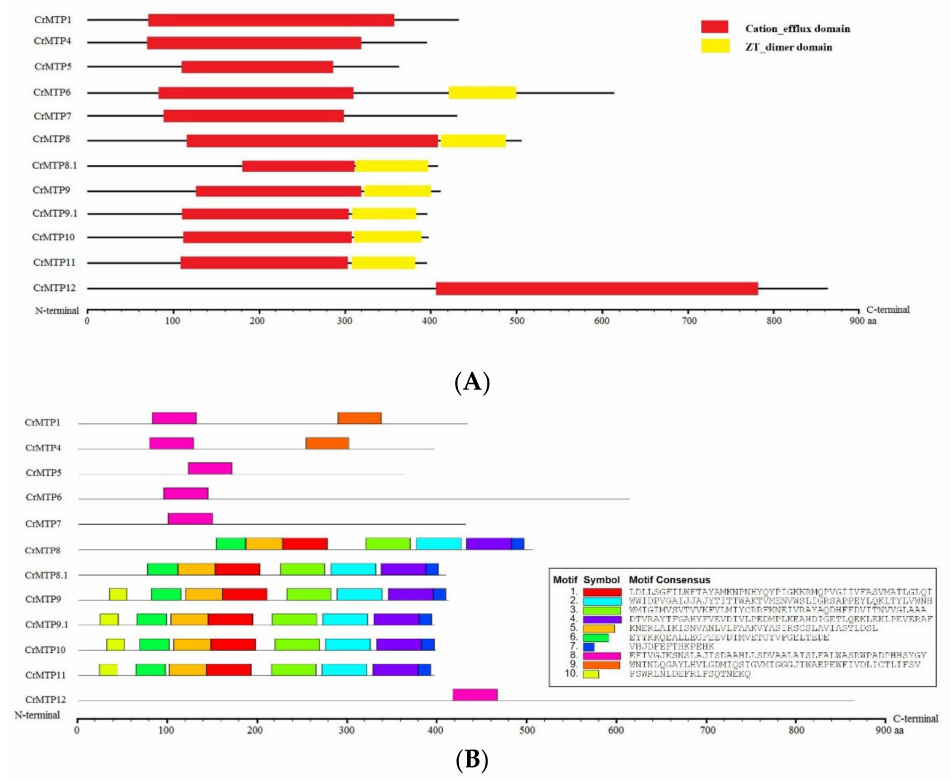
Figure 5. Conserved domains searched by the Pfam database and their conserved motifs discov- ered by Multiple Em for Motif Elicitation (MEME) motif discovery server of CrMTP proteins in C. rosea . ( A ) The protein families (PFAM) domain diagrams of CrMTPs, searched by PFAM database; ( B ) Conserved motifs of CrMTPs, identified using Multiple EM for Motif Elicitation (MEME) database. The websites of PFAM and MEME databases were listed in “Materials and Methods”